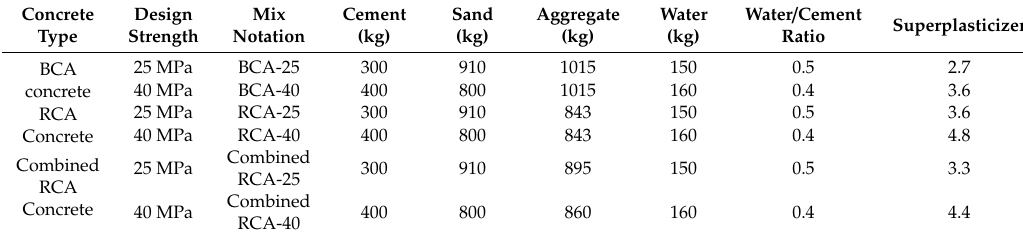
Table 2. Mix proportions used in concrete (kg / m 3 ).